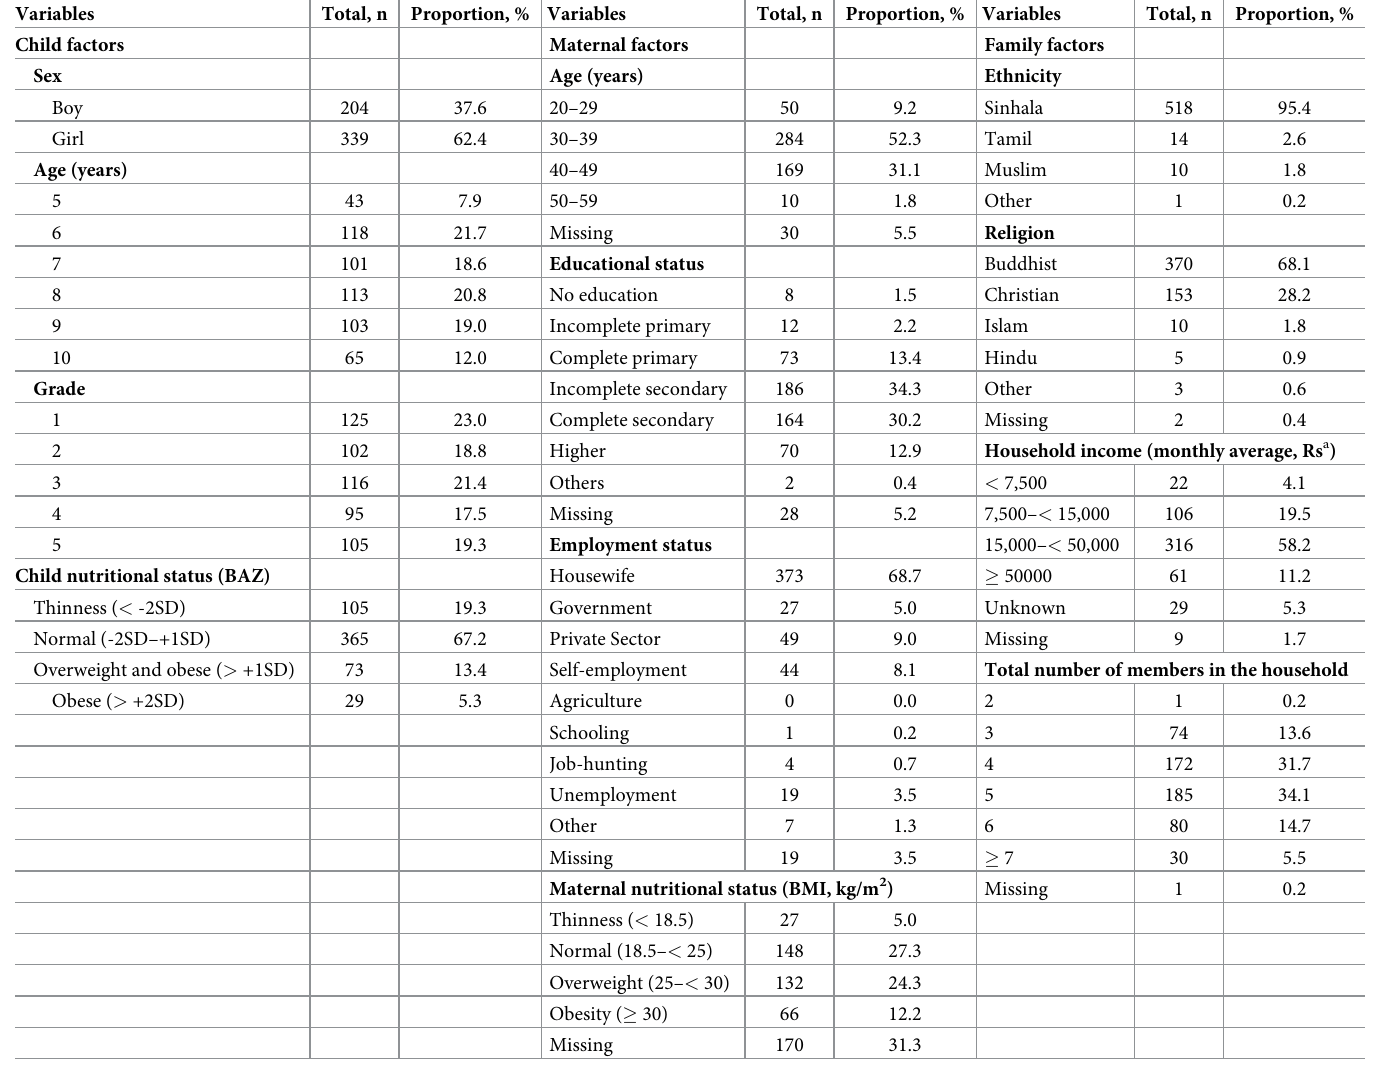
Table 1. Characteristics of the study population (n =